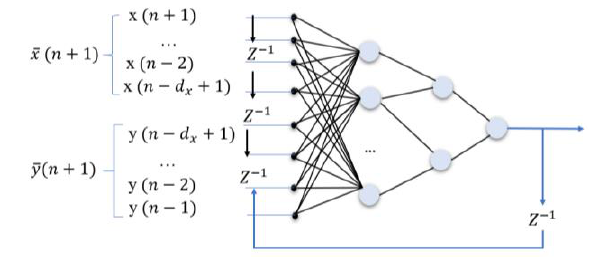
Figure 2. NARX structure (Z -1 is the unit time delay) (Roghanchi and Kocsis,